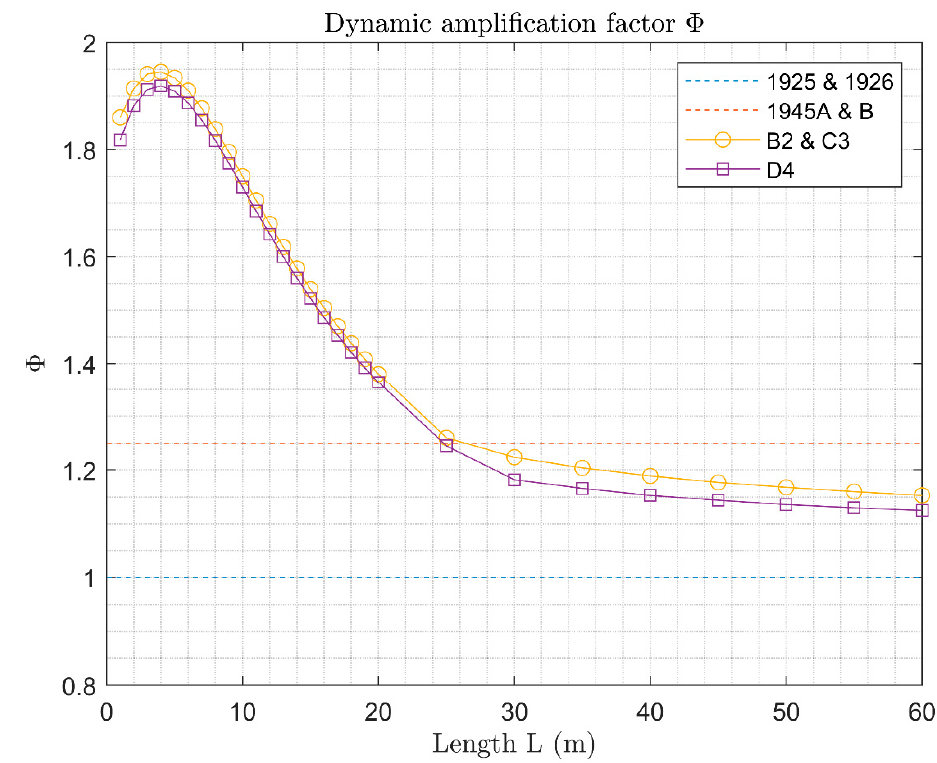
Figure 10. Dynamic amplification factors applied to different loads.